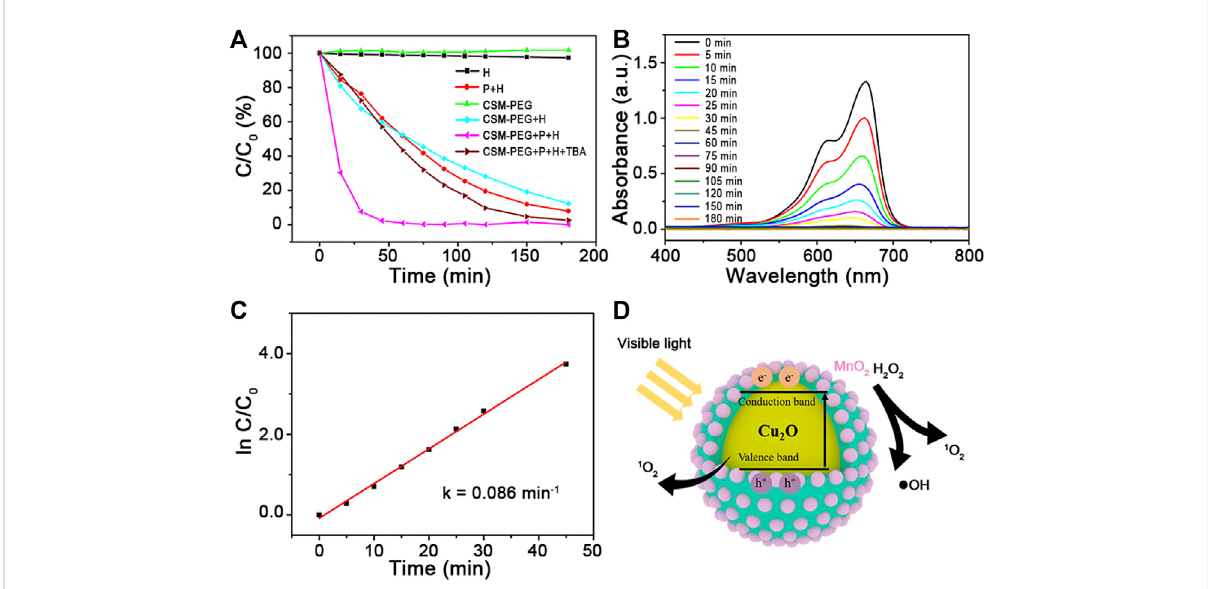
FIGURE 4 (A) Catalytic activities of Cu 2 O@SiO 2 /MnO 2 − PEG for degradation of MB under different conditions. (B) UV − Vis spectra measured for the MB solution versus time in the presence of visible light and H 2 O 2. (C) The kinetic fi tting lines for H 2 O 2 − enhanced photodegradation of MB over Cu 2 O@